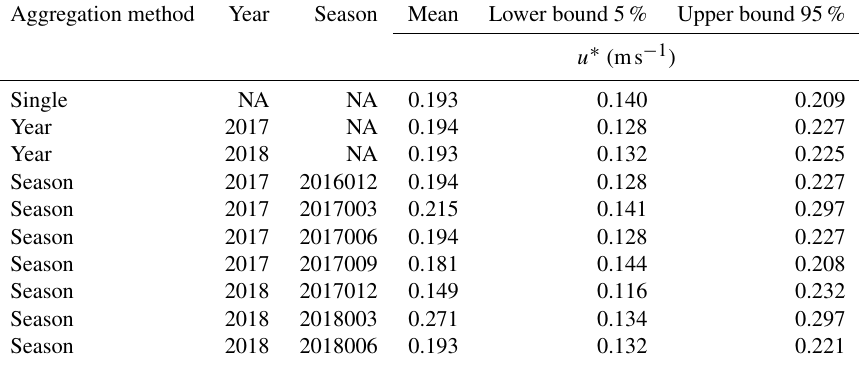
Table A1. Threshold of velocity friction ( u ∗ ) above which nighttime fluxes were considered valid. Estimates were obtained using the R package REddyProc. We used only the flux records with u ∗ equal to or higher than the corresponding mean u ∗ threshold for each year. Bound values are a 95% confidence interval. NA: not